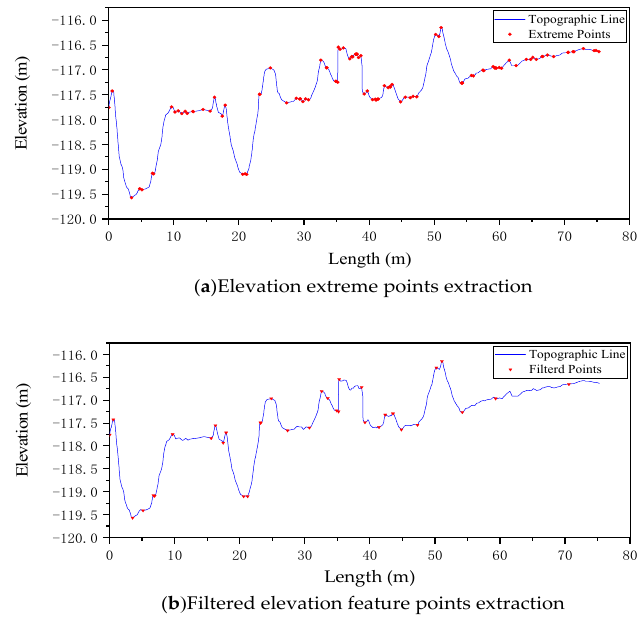
Figure 3. Schematic diagram of feature point extraction. In ( a ), the red dots are the extreme points on the section scanning line. In ( b ), the red marks are the feature points filtered according to the threshold 𝑇 , and only the points with large elevation change are retained. The x-axis, which depends on the size of the point set represents the length of the scanline; the y-axis represents the elevation value of the point on the scanline.